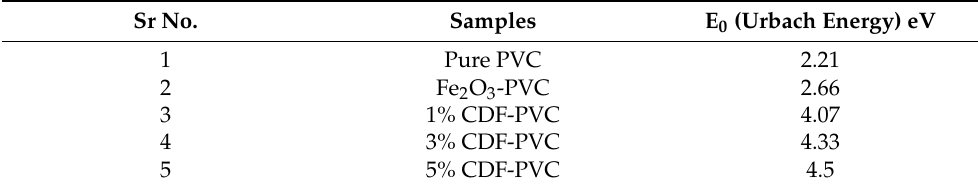
Table 3. Urbach energies of PVC composites.